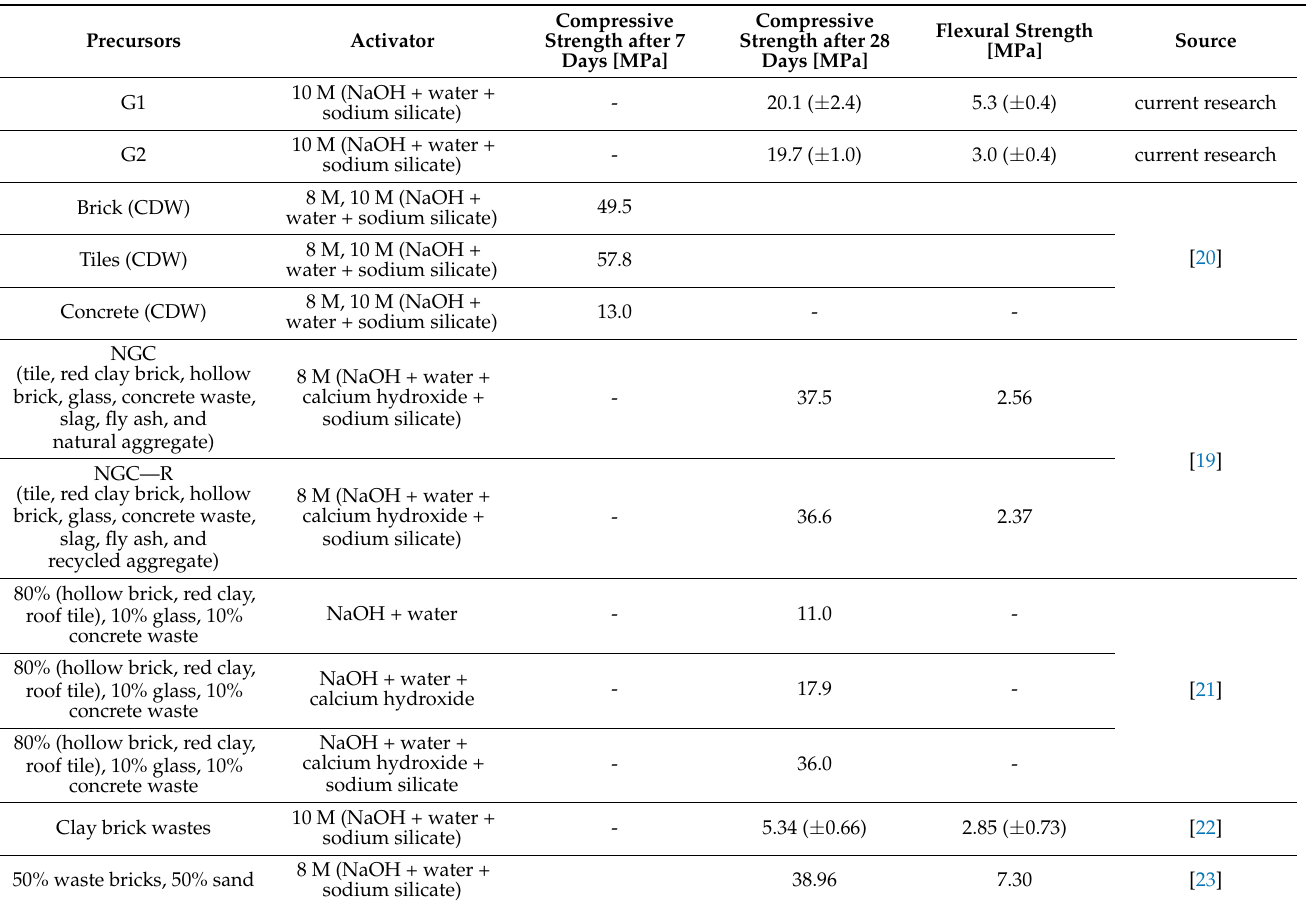
Table 6. Comparison of strength properties with literature